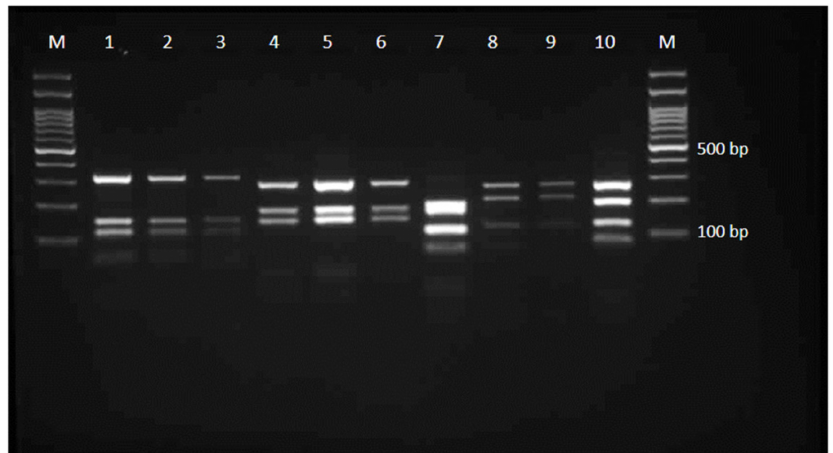
Figure 2. Electrophoretic profiles obtained with representative dermatophyte isolates for ITS-rDNA digested with MvaI. Lanes 1–3 = N. fulva , 4–6 = N. gypsea , 7 = A. tuberculatum , 8–9 = A. gertleri and 10 = A. quadrifidum